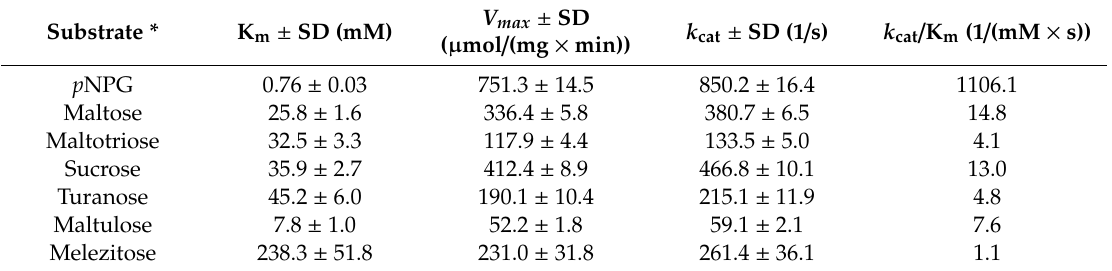
Table 1. K m , V max , k cat and k cat / K m values of hydrolysis of p NPG and sugars by Ba